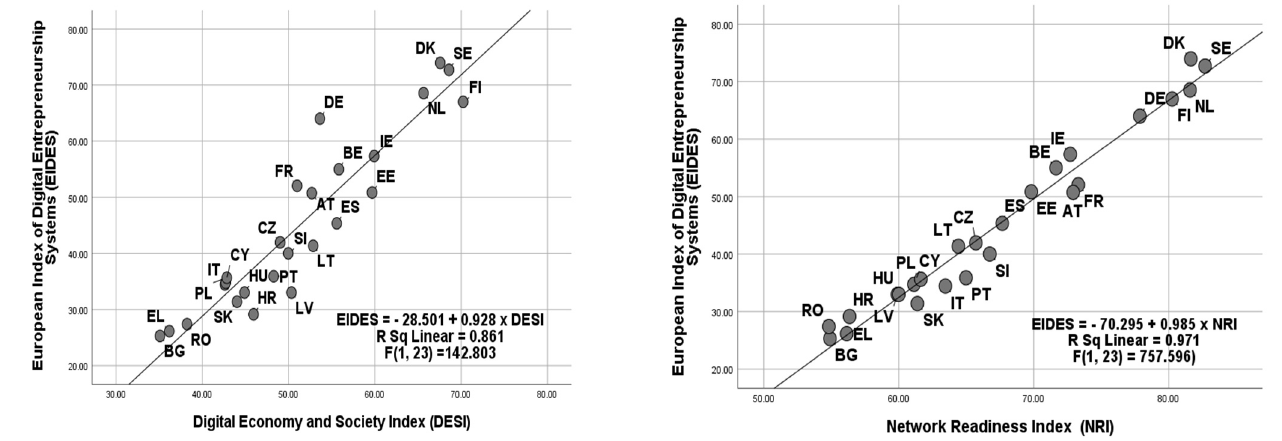
Figure 2. Positive link between digital entrepreneurship and the digitalization of an economy and society. Source: own calculations based on [26,82,89,91].